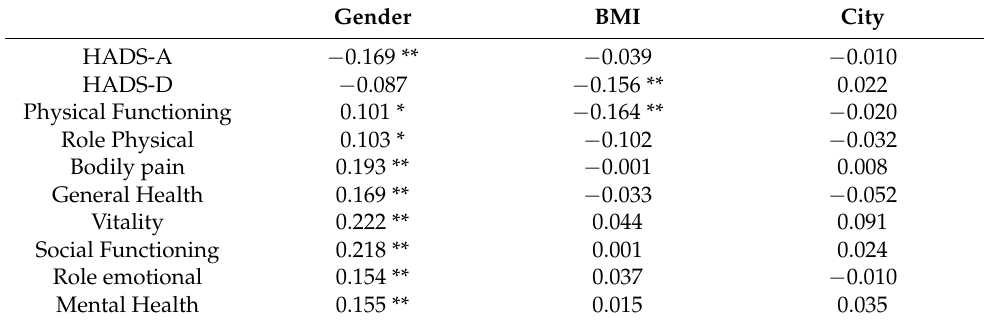
Table 2. Pearson Correlation of Anxiety, depression and health-related quality of life (HRQoL) scores (means and SD) by demographic